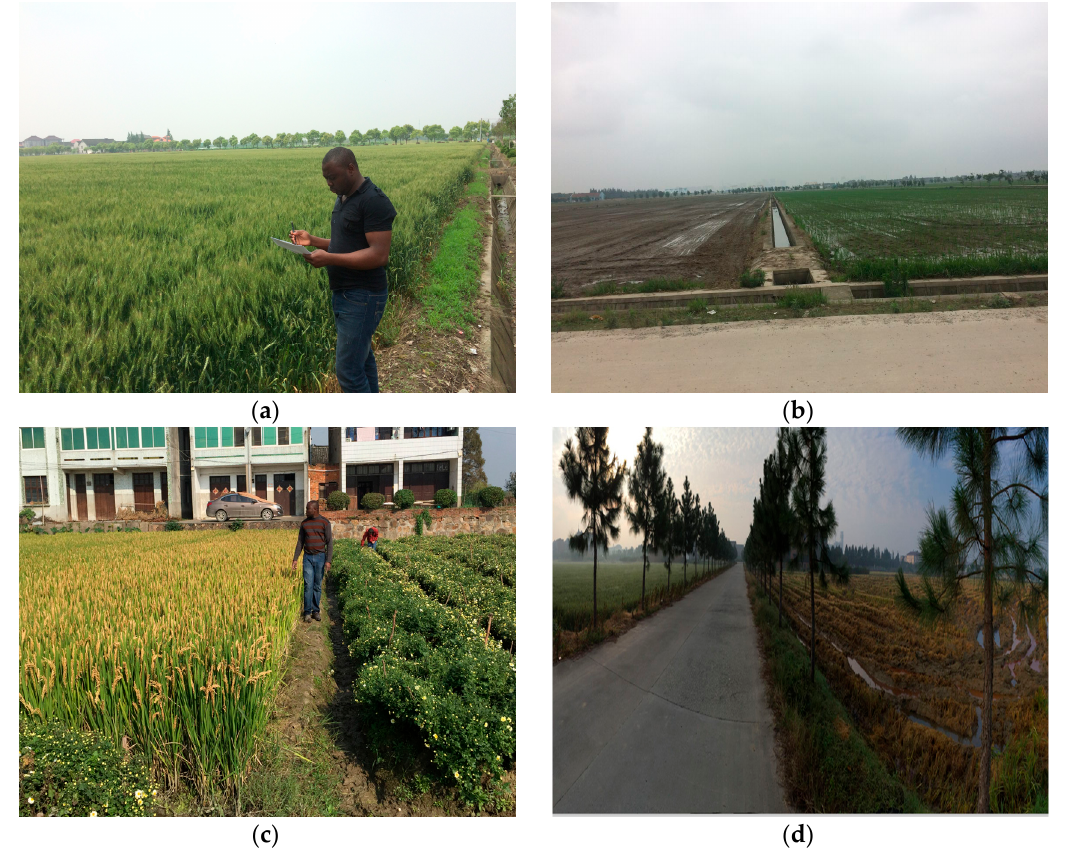
Figure 2. Spatial dynamics of rice cultivation in the study area: ( a ) field showing winter wheat at maturity in April 2016, but previously cultivated with rice in 2015; ( b ) field showing inter-field variability in rice planting time in June 2016, with the right part already planted and the left part prior to planting; ( c ) field showing a small rice plot (smallholder rice field) at maturity surrounded by residential and another agricultural land-use in November 2016; and ( d ) field showing adjacent rice plots in November 2016, one harvested and the other at maturity.